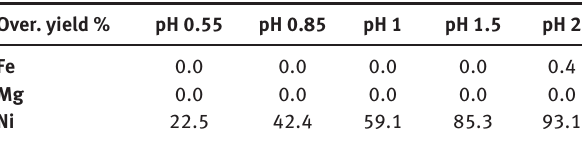
Table 3: Overall yield of ion exchange depending on solution pH, using 25 ppm Ni, 2.7 g/L Mg, 0.5 g/L Fe. Over. yield %